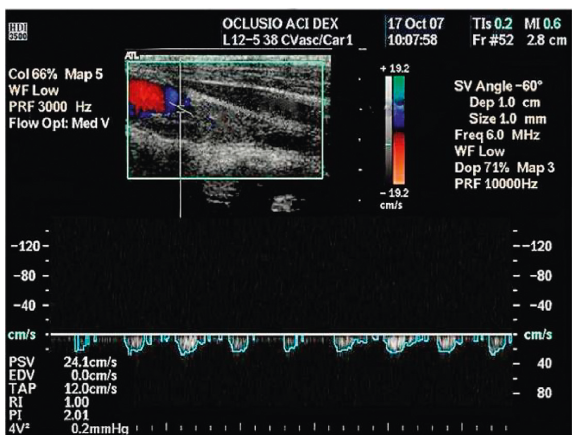
Figure 1: CDS findings of the ICA occlusion.